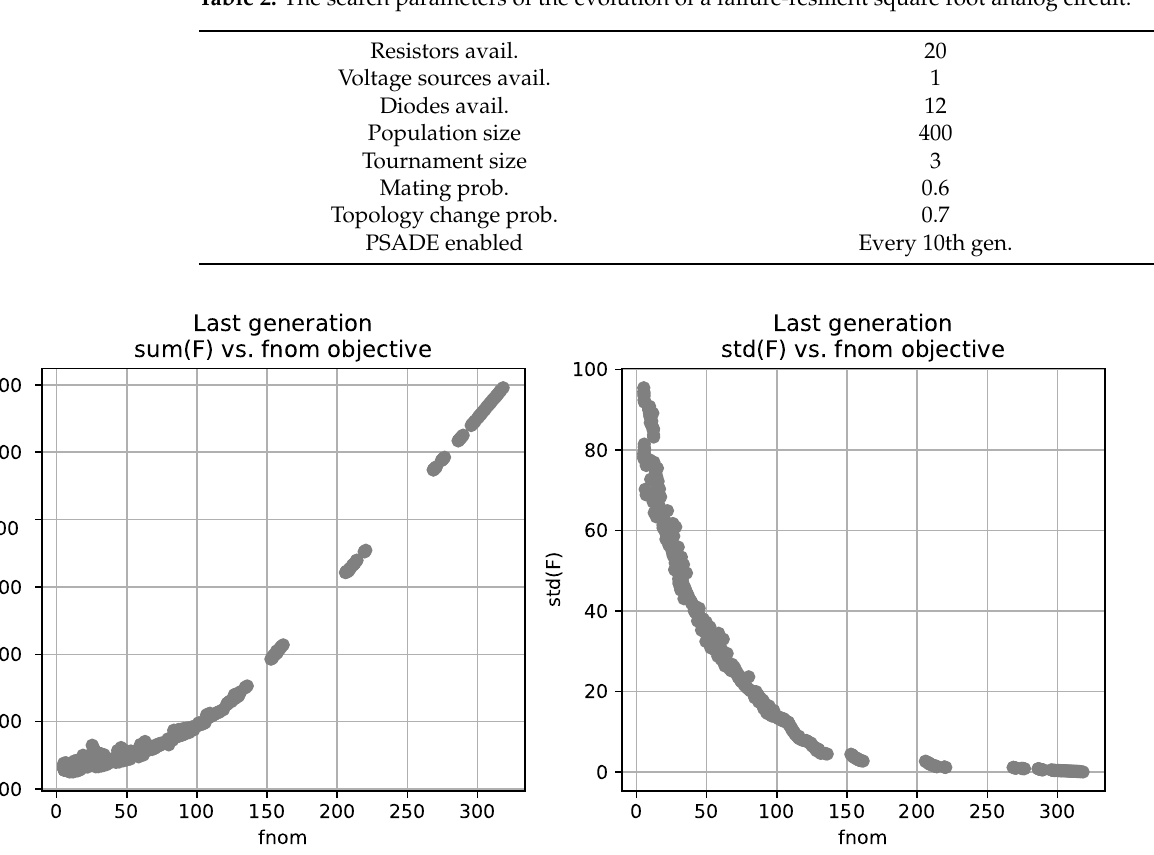
Figure 6. The Pareto front of the last generation of the evolution of the failure-resilient square root circuit. Shown are the tree objectives f nom , F Σ , and σ F